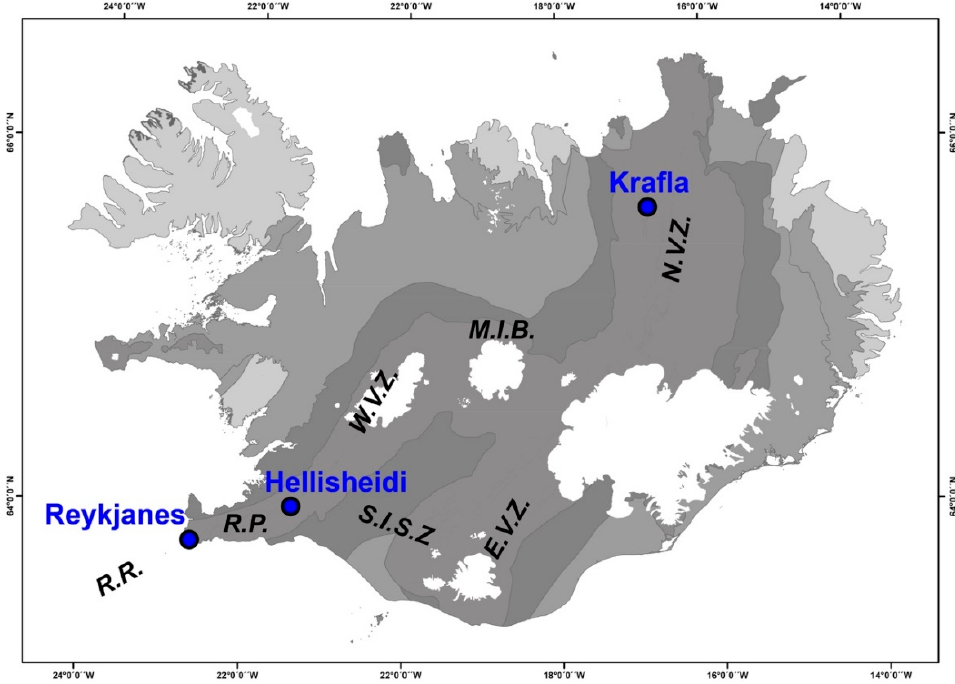
Figure 1. Simplified geological map of Iceland [17]. The darker the color, the younger the stratigraphic unit. The location of the Krafla, Hellisheidi and Reykjanes geothermal fields are marked by circles. The main volcanic provinces and structural zones are marked as: N.V.Z: North Volcanic Zone, M.I.B.: Mid Iceland Belt, W.V.Z.: West Volcanic Zone, E.V.Z.: East Volcanic Zone, R.P.: Reykjanes Peninsula, R.R.: Reykjanes Ridge, S.I.S.Z.: South Iceland Seismic Zone.